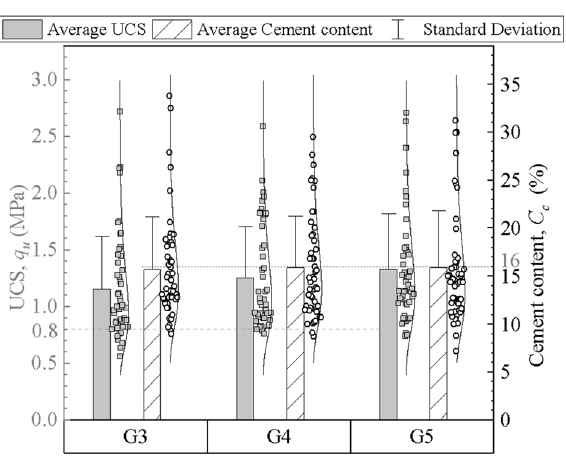
Figure 12. Cement content and UCS of the columns of groups #G3, #G4 and